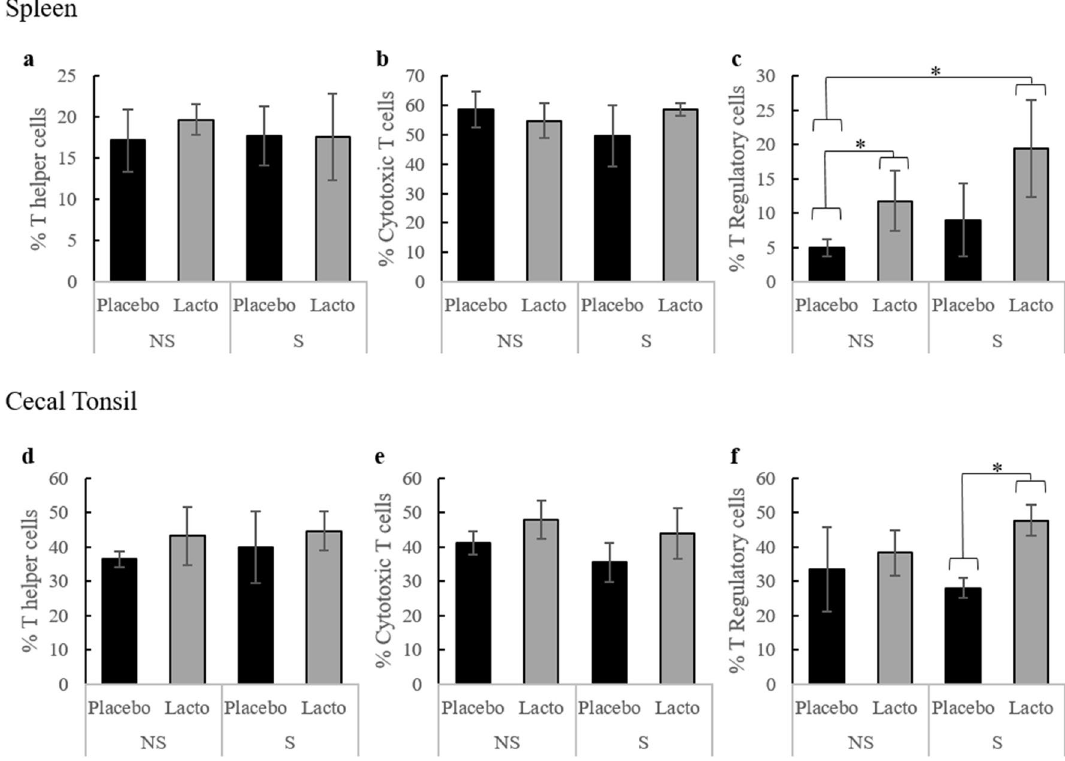
Figure 4. T cell sub-populations in the spleen and cecal tonsils. T cell sub-populations in the spleen ( a – c ) and cecal tonsils ( d – f ) after three weeks of L. rhamnosus (Lacto) or placebo (Placebo) supplementation and stress treatment (S: stressed, NS: non-stressed). Sub-populations were identified using the following combinations of cell surface markers: T helper cells = CD3 + CD4 + ; cytotoxic T cells = CD3 + CD8 + ; T regulatory cells = CD4 + CD25 + (n: S-Placebo = 4, NS-Placebo = 4, S-Lacto = 4, NS-Lacto = 4). Asterisks (*) indicate statistically significant differences (P <